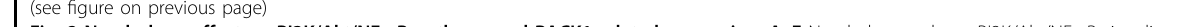
Fig. 2 Nandrolone effect on PI3K/Akt/NF- κ B pathway and RACK1-related expression. A – F Nandrolone reduces PI3K/Akt/NF- κ B signaling pathway and RACK1-related expression. A – B MCF7 cells were treated for 24 h with 100 nM of testosterone (T), testosterone-BSA-FITC (T-BSA) or nandrolone (N). Vehicle controls were treated with DMSO < 0.1% (CTRL). The images are representative Western Blots. Results are shown as p-Akt/Akt ( A ), p-I κ B α /I κ B α ( B ) ratios ± SEM of four independent experiments. C Analysis of c-Rel expression in nucleus fraction of MCF7 cells treated for 24 h with 100 nM of testosterone-BSA-FITC (T-BSA) or nandrolone (N). Vehicle controls were treated with DMSO < 0.1% (CTRL). The image is a representative Western blot and results are shown as c-Rel/Lamin A/C ratio. Each value in the graph represents the mean±SEM of four independent experiments. A – C Statistical analysis was performed with Dunnett ’ s multiple comparison test with * p < 0.05, ** p < 0.01, *** p < 0.001. D MCF7 cells were transiently transfected with Δ 1, Δ 2, Δ 7, and Δ 11 RACK1 promoter constructs. Δ 1 is the longest construct available and contains all three c-Rel sites. Δ 2 luciferase reporter construct contains only the two cis c-Rel sites whereas Δ 11 and Δ 7 contain one of the two cis c-Rel sites as described in ref. 34 . The basal activity of these luciferase reporter constructs was evaluated through luciferase assay. Luciferase activity was expressed as RLU% and compared to Δ 1 values assumed at 100%. Each bar represents the mean ± SEM of three independent experiments, in quadruplicate. Statistical analysis was performed with Dunnett ’ s test, with ** p < 0.01, **** p < 0.0001. E MCF7 cells were transiently transfected with Δ 7 and subsequently were treated for 16 h with 100 nM of testosterone-BSA-FITC (T-BSA), nandrolone (N) or with 10 µM BAY 11-7085. Vehicle controls were treated with DMSO < 0.1% (CTRL). Luciferase activity was expressed as RLU% and compared to CTRL values assumed at 100%. Each bar represents the mean±SEM of three independent experiments, in triplicate. Statistical analysis was performed with Tukey ’ s test, with ** p < 0.01, **** p < 0.0001 vs CTRL and with §§ p < 0.01 vs T-BSA. F MCF7 cells were treated for 24 h with 100 nM of testosterone-BSA-FITC (T-BSA) or nandrolone (N). Vehicle controls were treated with DMSO < 0.1% (CTRL). The images are representative Western Blots. Results are shown as RACK1/ β -tubulin ratio ± SEM of four independent experiments. Statistical analysis was performed with Tukey ’ s test, with ** p < 0.01 vs CTRL and with § p < 0.05 vs T-BSA. G – I MDA-MB-231 cells were treated for 24 h with 100 nM nandrolone. Vehicle controls were treated with DMSO < 0.1% (CTRL). The images are representative Western Blots. Results are shown as p-Akt/Akt ( G ), p-I κ B α /I κ B α ( H ) and RACK1/ β -tubulin ( I ) ratios ± SEM of three independent experiments. Signi fi cance was set at p < 0.05 by the Student ’ s t -test (* p <